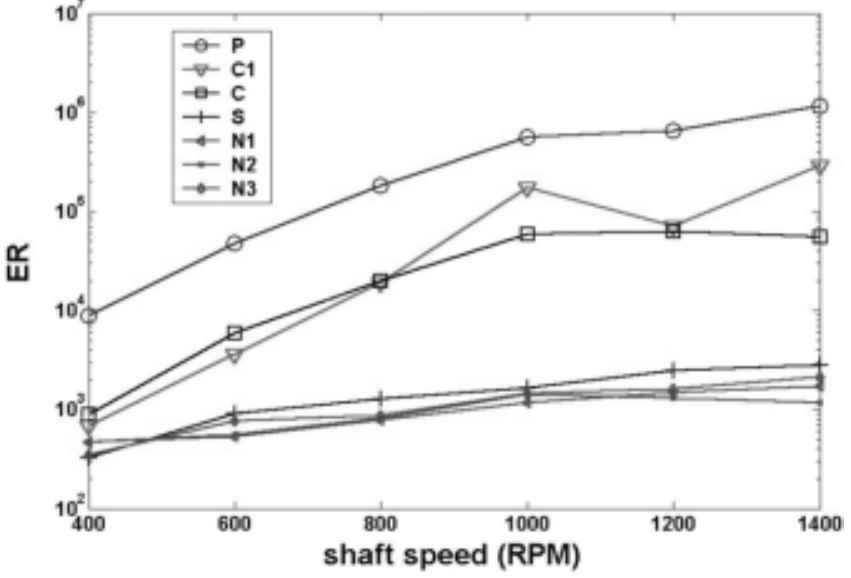
Fig. 11. ER of the acceleration signal as a function of the rotating shaft speed, load 2.